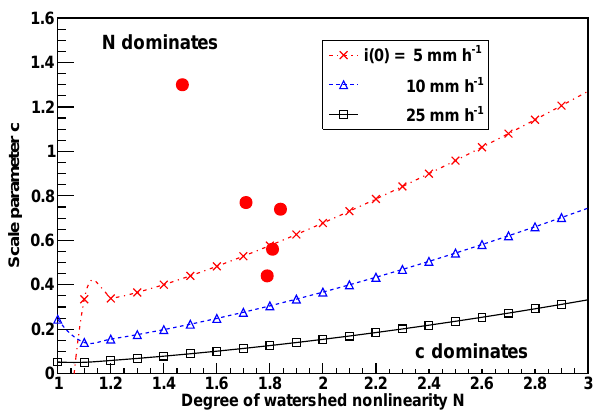
Fig. A1. The iso-sensitivity lines of the variable IUH model param- eters. In terms of the change of the unit hydrograph peak ordinate, above each of the constant rainfall excess intensity lines, it is more sensitive to change in parameter N than in c , and vice versa. For comparison, the calibrated parameter values for all five storms on the Edwardsville, Illinois, watershed, are shown as red